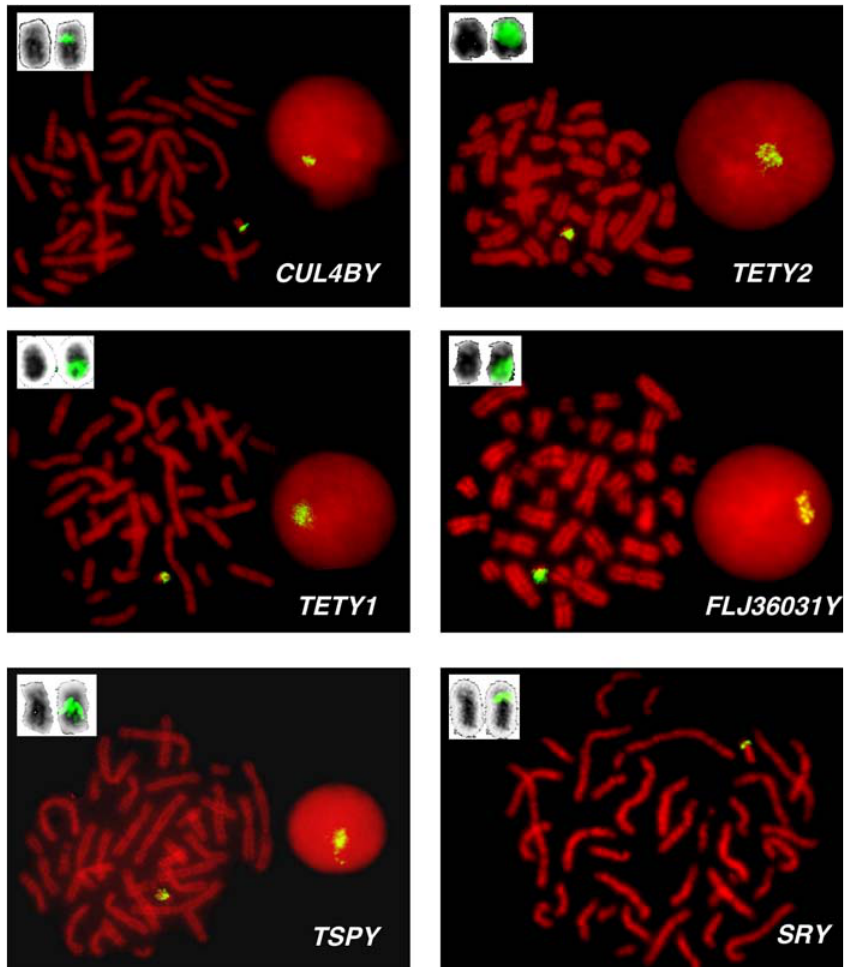
Figure 5. Multicopy Distribution of Novel Y Chromosome cDNAs Confirmed by FISH FISH of feline cDNA probes on male domestic cat metaphase preparations. For each novel gene, the signal is detected only on the Y chromosome and is generally restricted to the long arm. Note that no hybridization signals were found on the distal short arm, which is heterochromatic [30]. For multicopy genes we also show the hybridization results on interphase nuclei. An SRY -containing BAC clone hybridized to the short arm of the Y chromosome near the centromere. A magnified view of the reverse-DAPI banded Y chromosome is shown in the upper left corner of each image, both with (right) and without (left) hybridization signals. DOI: 10.1371/journal.pgen.0020043.g005